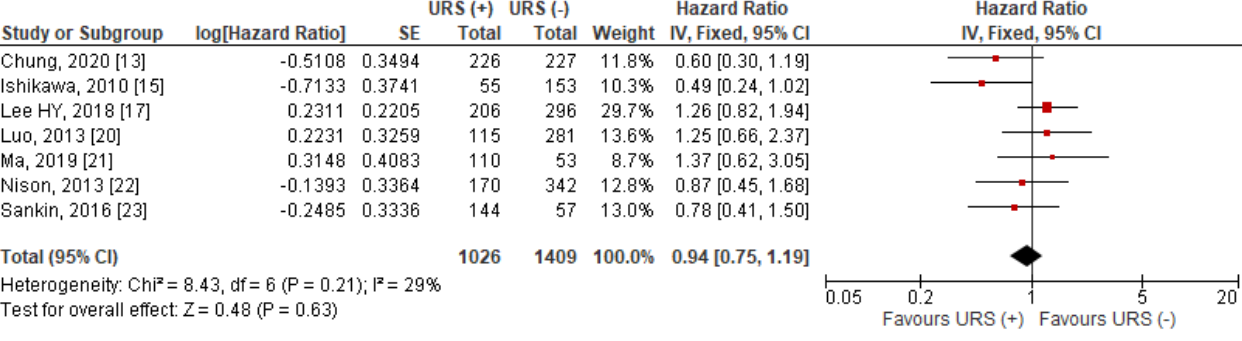
Figure 4. Forest plot and meta-analysis of cancer-specific survival (CSS) [13,15,17,20–23]. CI = confidence interval; IV = inverse variance; SE = standard error; URS = ureteroscopy.